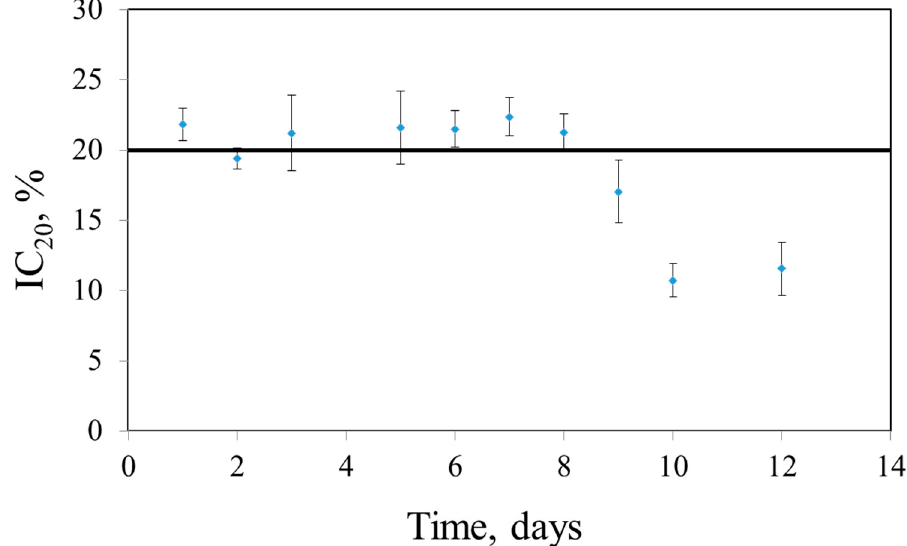
Figure 6. Long-time stability of the ferrocene– P. yeei –Cu 2+ system. Table 6. Analytical characteristics of the developed systems.